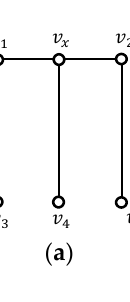
Figure 8. Investigating the number of outer segments adjacent to an intersection vertex v x ( a ) Ω ( v x ) = 0; ( b ) Ω ( v x ) = 1; ( c ) Ω ( v x ) ≥ 2.